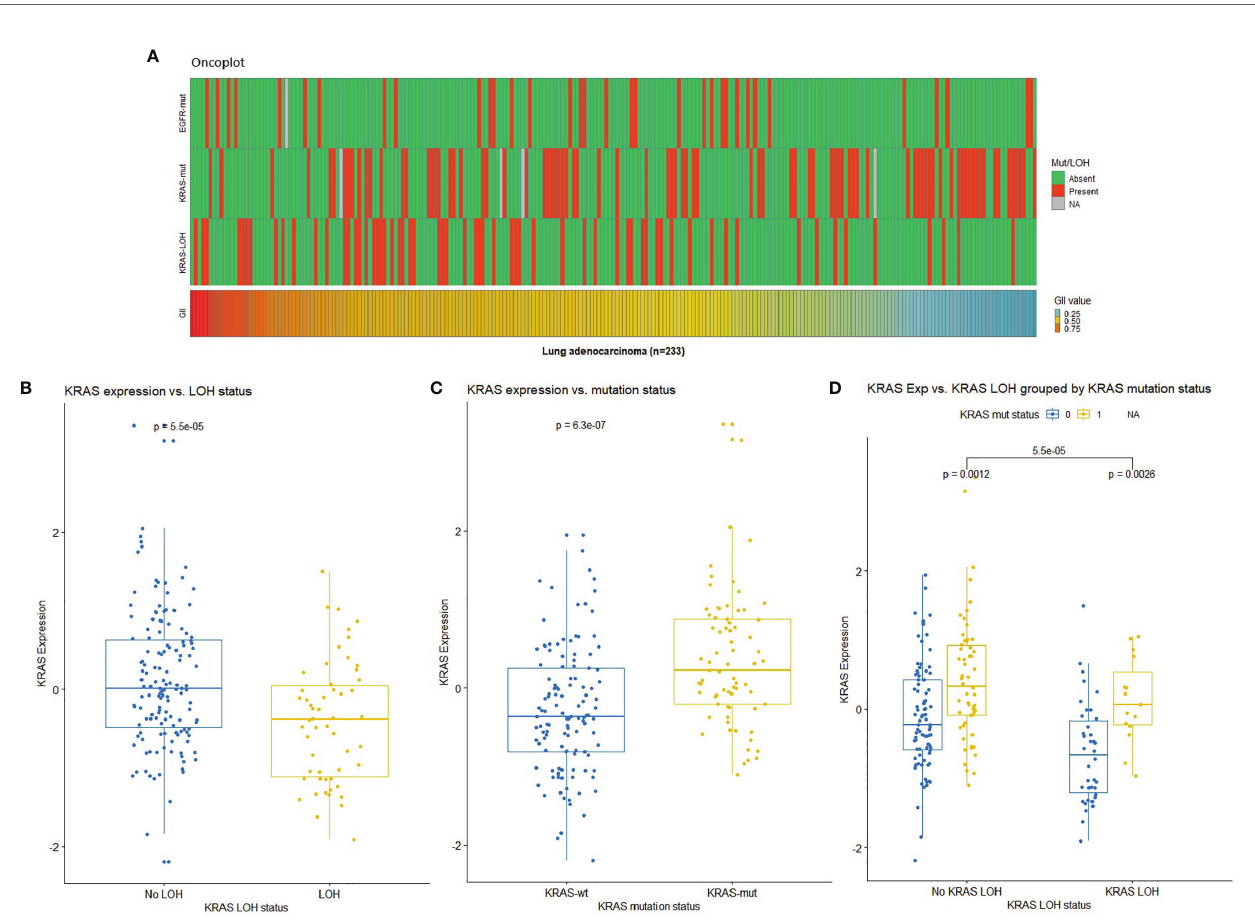
FIGURE 1 | (A) Oncoplot showing mutation status in EGFR and KRAS (red: mutated, green: wild-type, gray: missing), loss of heterozygosity (LOH) at the KRAS locus (red: LOH, green: no LOH), and genomic instability index (GII) in the Oslo cohort (red: high, blue: low). (B) KRAS expression by KRAS LOH status indicating higher expression in samples with no LOH in KRAS . (C) KRAS expression by KRAS mutation status indicating high expression in samples with KRAS mutation (wt: wild-type; mut: mutation). (D) KRAS expression by KRAS LOH status grouped by KRAS mutation status in lung adenocarcinomas with respect to KRAS LOH and mutation status [0: wild-type (blue); 1: mutation (yellow)]. NA, Not